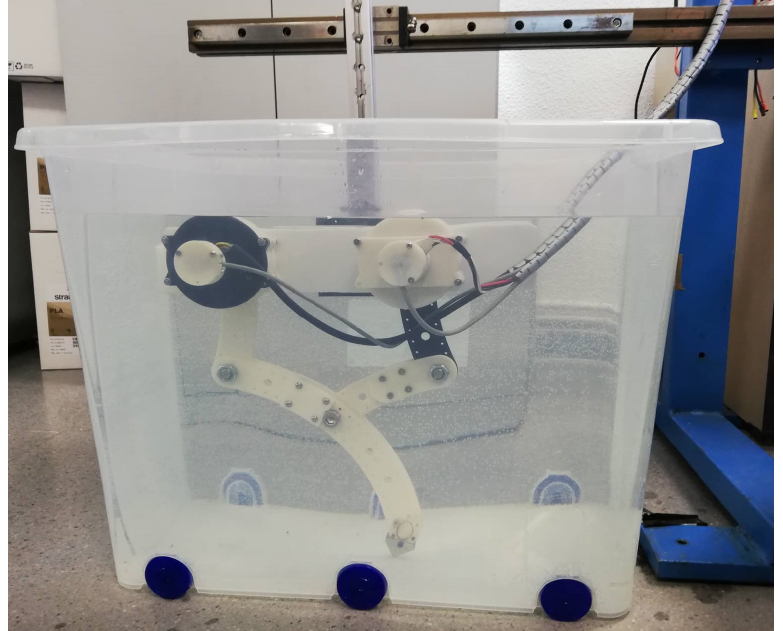
Figure 16. Prototype testbed in underwater